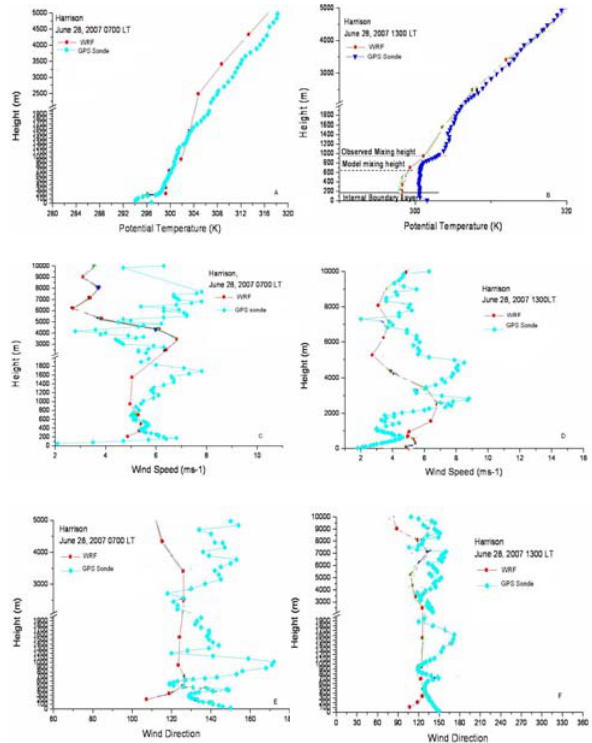
Figure 14 : Simulated and observed vertical profiles of potential temperature at 07 UTC (a), 13 UTC (b), wind speed at 07 UTC (c), 13 UTC (c) and wind direction at 07 UTC (e), 13 UTC (f) for the Harrison location